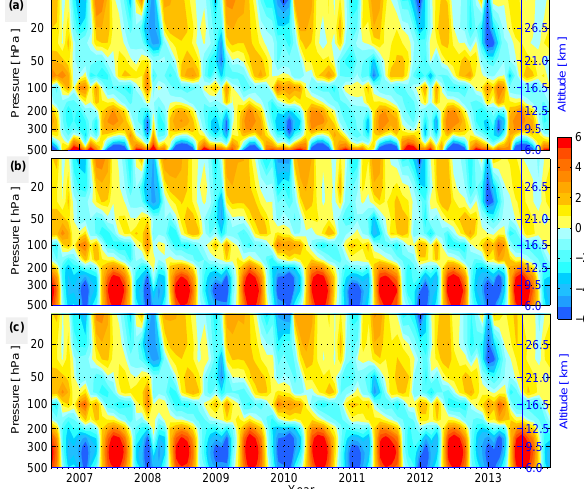
Figure 4. Temporal evolution of temperature ( ◦ C) with the time mean removed at each pressure level (500–10hPa) based on (a) COSMIC RO, (b) MERRA, and (c) ERA-Interim. Data span be- tween August 2006 and December 2013 and contain area-average over the region (16–35 ◦ N, 71–100 ◦ E) covering the GBM river basin.